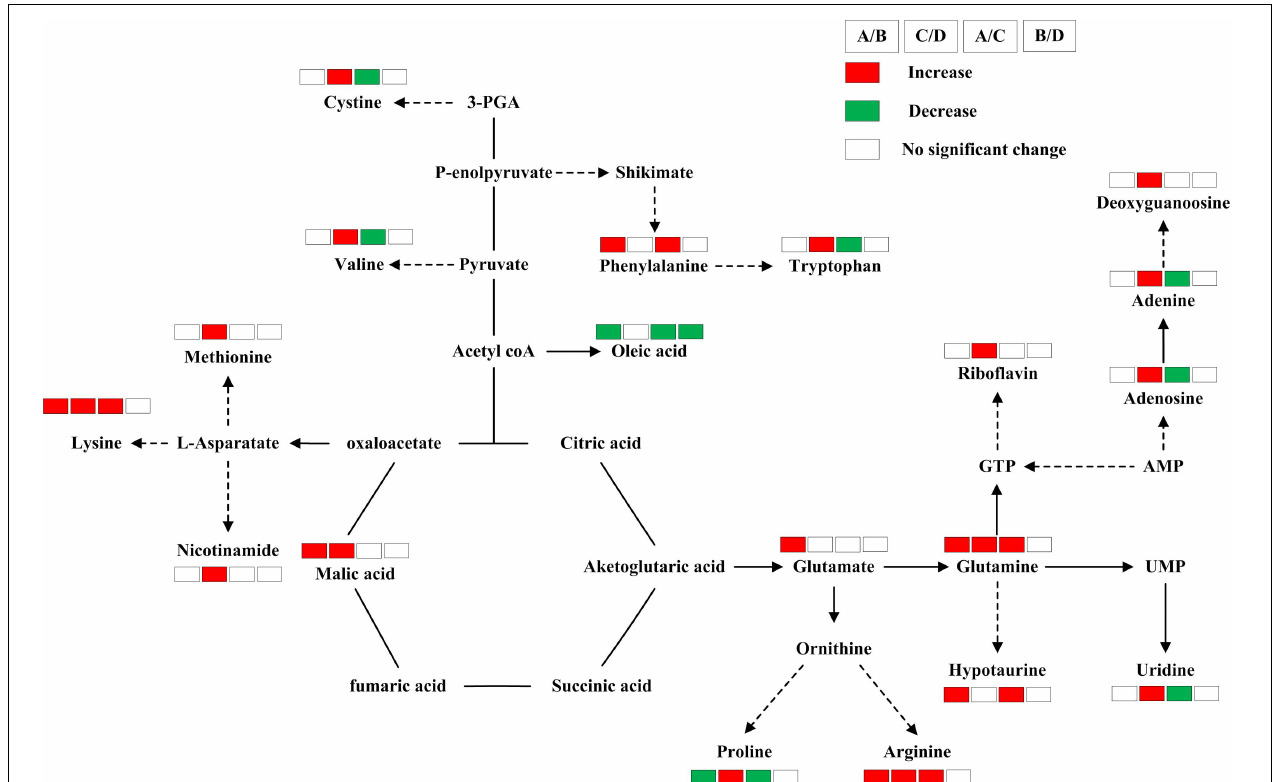
FIGURE 4 | Metabolic changes involved in the primary pathways of Huidan No. 4 and Ludan No. 8 under lead exposure and lead-free treatments. Huidan No. 4 lead-free treatment (A) , Huidan No. 4 exposed to lead (B) , Ludan No. 8 lead-free treatment (C) , and Ludan No. 8 exposed to lead (D) . Metabolites with red boxes denote significant increases while with green ones denote significant decreases. The levels of significance was set at P <